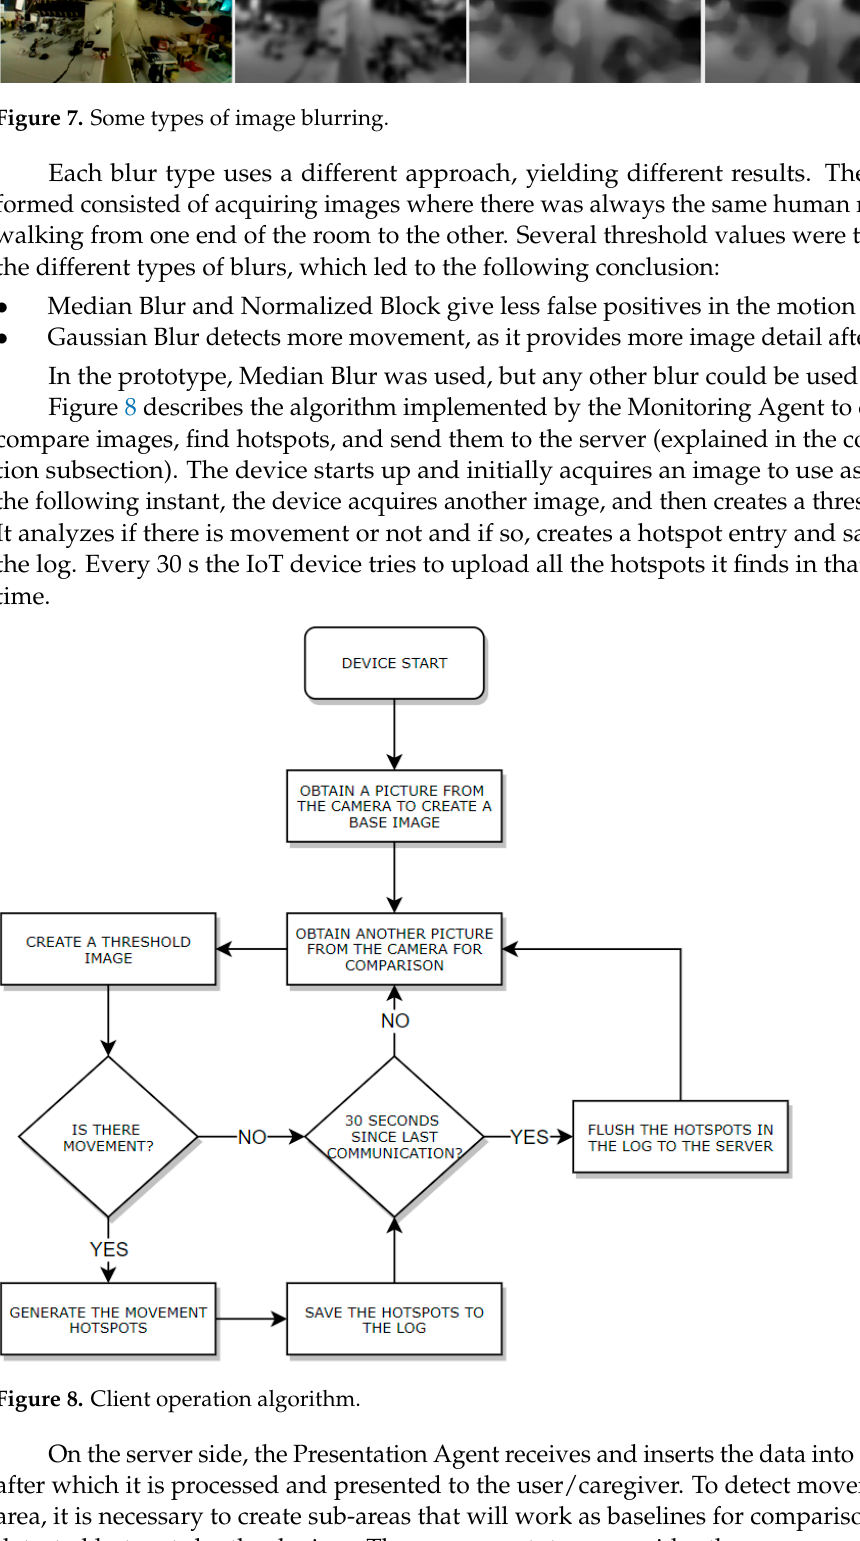
Figure 9. Management of zones and subzones. This management feature allows the administrator/system installer to create the zones and the respective subzones that the caregiver want to supervise. It should be noted